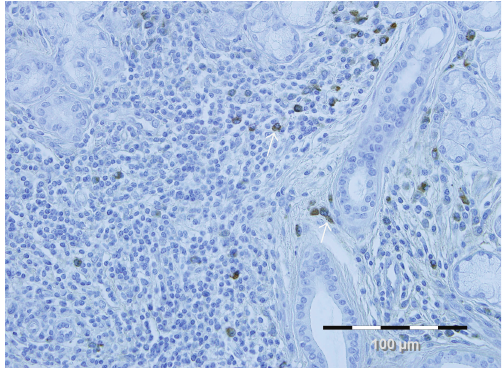
Figure 2: Infiltration of IgG4-positive plasma cells in LSGB of patients with SS. Sections of LSGB were immunostained with hematoxylin and eosin (H&E) and anti-IgG4 antibodies. Diaminobenzidine (in brown on the picture showed by white arrows) was used as the reagent to visualize the antigenic